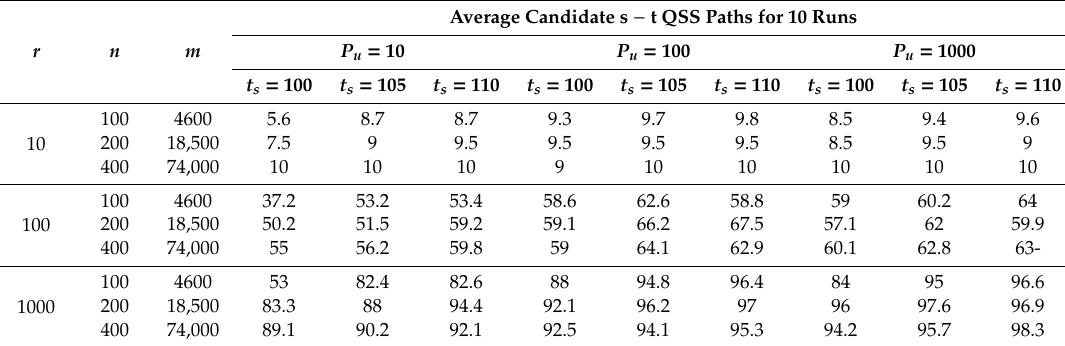
Table 8. Average candidate s − t QSS paths for the SESE algorithm for 1 Mb .